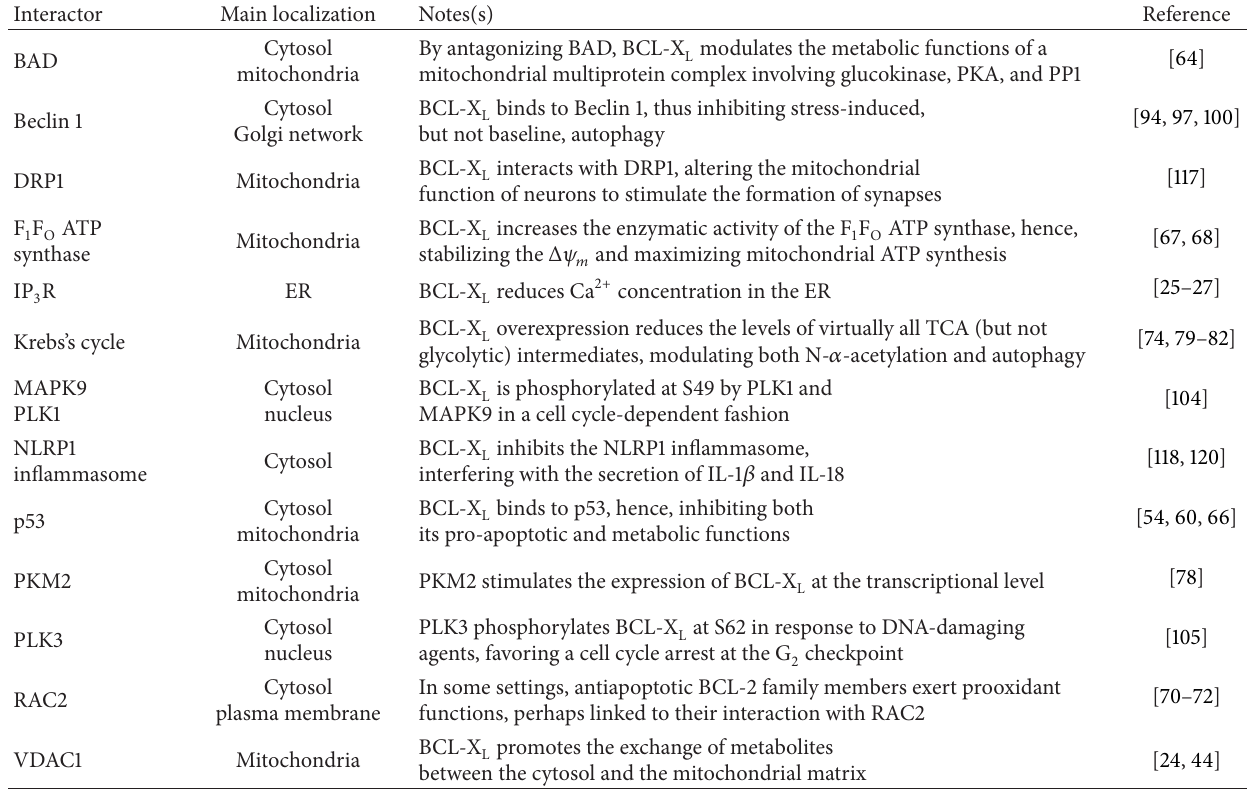
Table 1: Functions of BCL-X at the interface between cell death regulation and other aspects of the cell biology. L Interactor Main